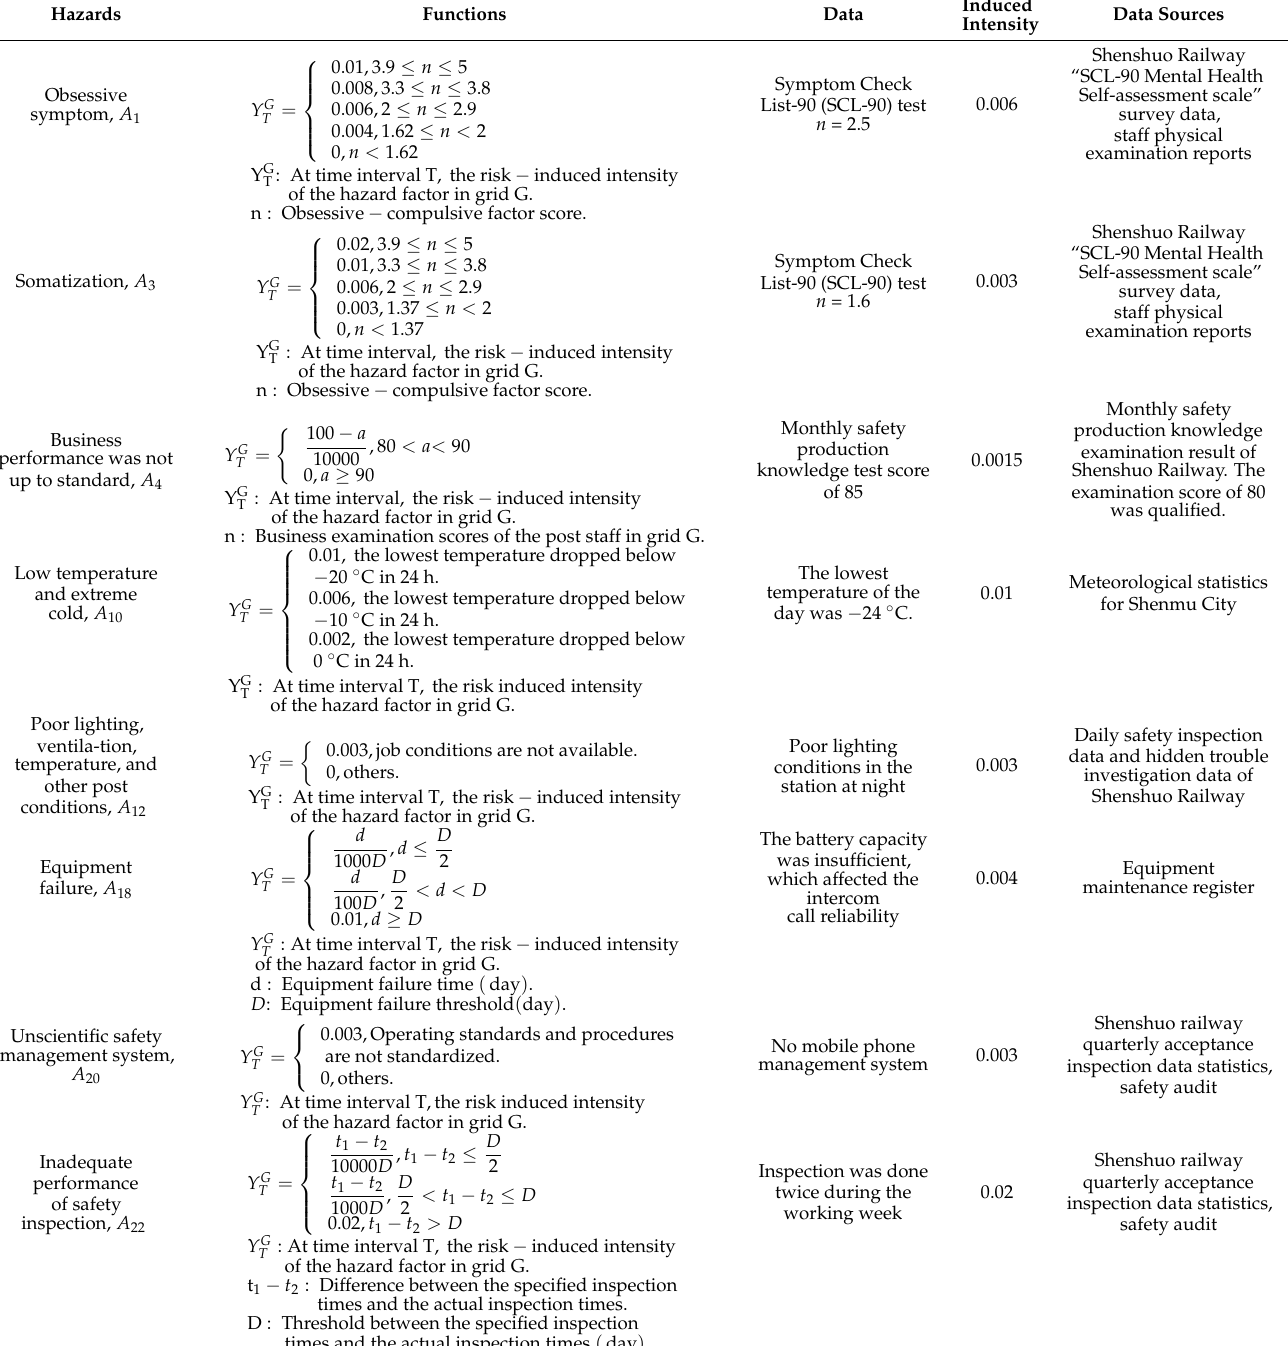
Table 8. The hazard factor data set of “the assistant watchman did not appear as